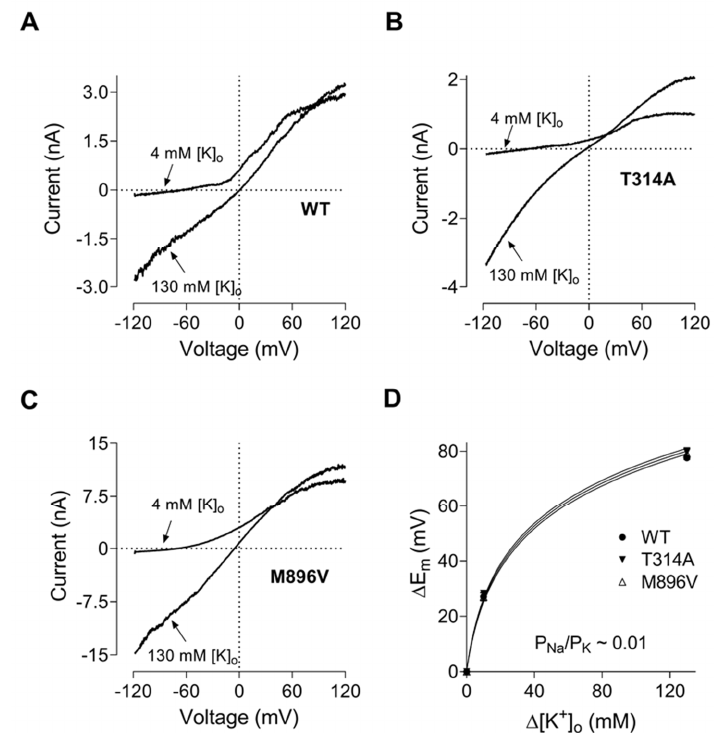
Figure 5. T314A and M896V GoF mutations do not alter KCNT1 pore permeability to Na + . ( A ). WT KCNT1. ( B ). T314A KCNT1. ( C ). M896V KCNT1. The I-V plots were recorded in response to 100 ms voltage ramps from − 120 mV to 120 mV in the control bath solution (4 mM K + ) and in a solution with 126 mM NaCl replaced with 126 mM KCl. ( D ). The shifts in the membrane potential caused by replacing NaCl with KCl were calculated using I-V plots similar to those shown in panels A-C and plotted against the KCl concentration changes. The solid curves are the fits of GHK equation (Equation (2), Section 4) to the experimental data.